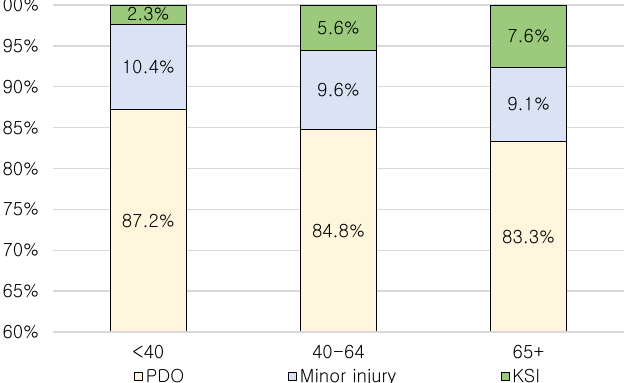
Figure 2. Crash proportion and frequency with respect to age classes. Table 2. Definitions and descriptive statistics of the candidate